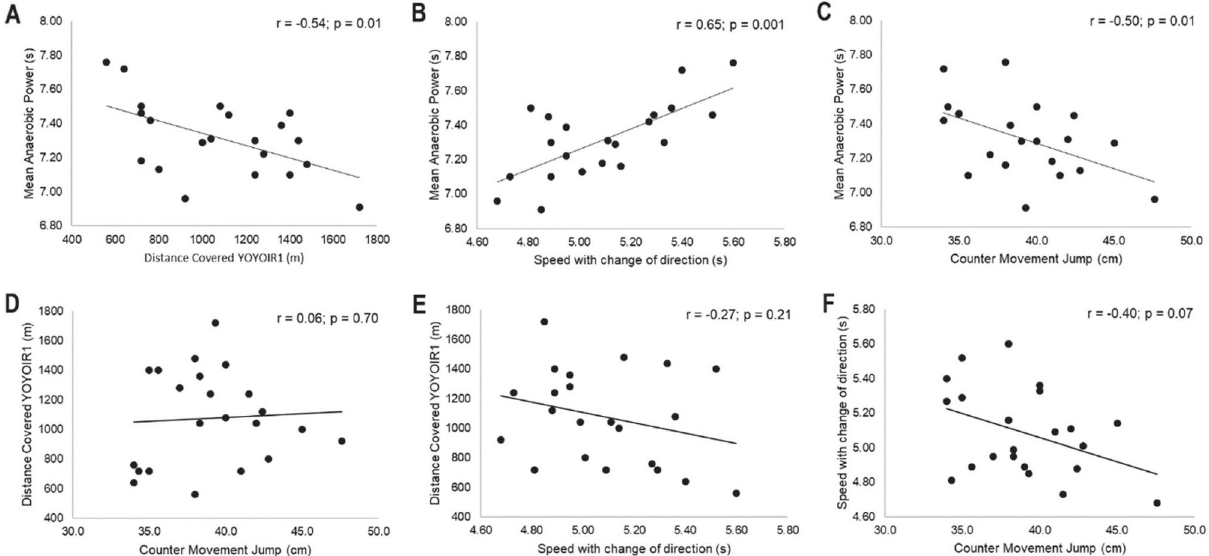
Figure 2 - The relationship between Mean Anaerobic Power (RSSA mean ) and distance covered in YOYOIR1 (A); RSSA mean and Speed with change direction (B); RSSA mean and Counter Movement Jump (C); distance covered in YOYOIR1 and Counter Movement Jump (D); distance covered in YOYOIR1 and Speed with change direction (E); and Speed with change direction and Counter Movement Jump (F). YOYOIR1: Yoyo Intermittent Recovery Test